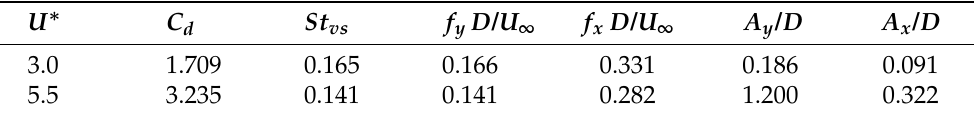
Table 2. Summary of the main statistical flow parameters. C d is the drag coefficient; St vs is the vortex- shedding frequency; f y D / U ∞ and f x D / U ∞ are non-dimensional cross-flow and inline oscillation frequency of the cylinder, respectively; and A y / D and A x / D are the maximum cross-flow and in-line cylinder amplitudes, respectively.